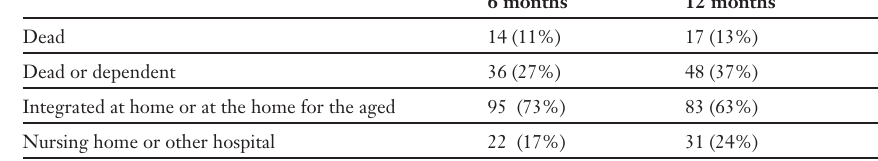
The outcome data are summarised after 6 and 12 months indi- cating a low mortality and a high percent- age of independent